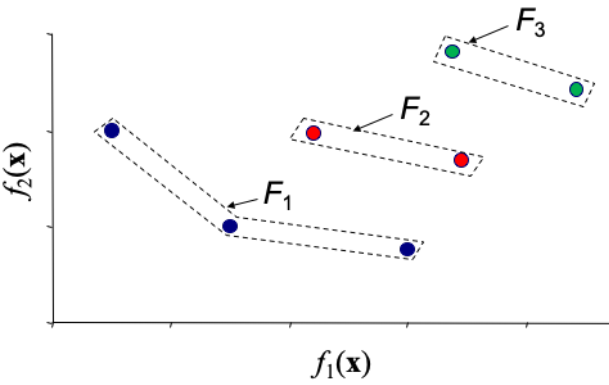
Figure 7. Non-dominated sorting procedure.